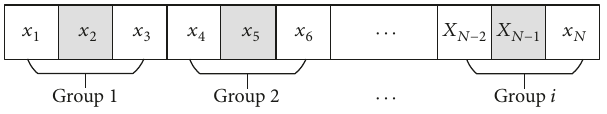
Figure 1: The use of 𝑁 samples as a frame and three samples as a group.